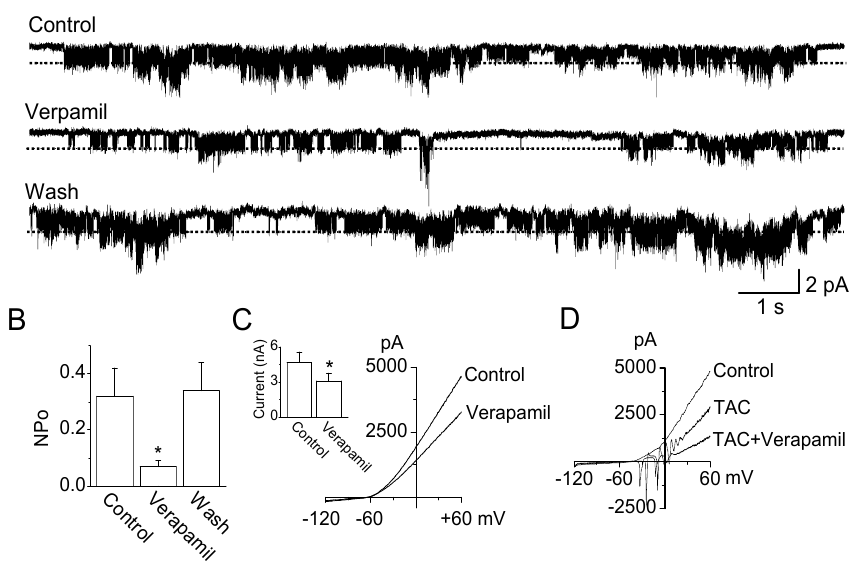
Figure 4. Effect of verapamil on the TRESK-like channel expressed in TG neurons. ( A ) The TRESK-like single-channel current was inhibited by the application of verapamil (10 µ M). Single-channel openings were recorded at 0 mV (pipette potential) in 5 mM K + solution; ( B ) Summary of the effects of verapamil on single-channel currents recorded from TG neurons. Data represent the mean ± SD of three repeated experiments. * p < 0.05 compared with the control; ( C ) Whole-cell currents were inhibited by verapamil. The current levels at +60 mV were determined and analyzed. Data represent the mean ± SD of three repeated experiments. * p < 0.05 compared with the control; and ( D ) Effect of verapamil on whole-cell currents recorded from TG neurons in the presence of voltage-dependent K + channel blockers. TAC represents combination of TEA, 4-AP, and CsCl.